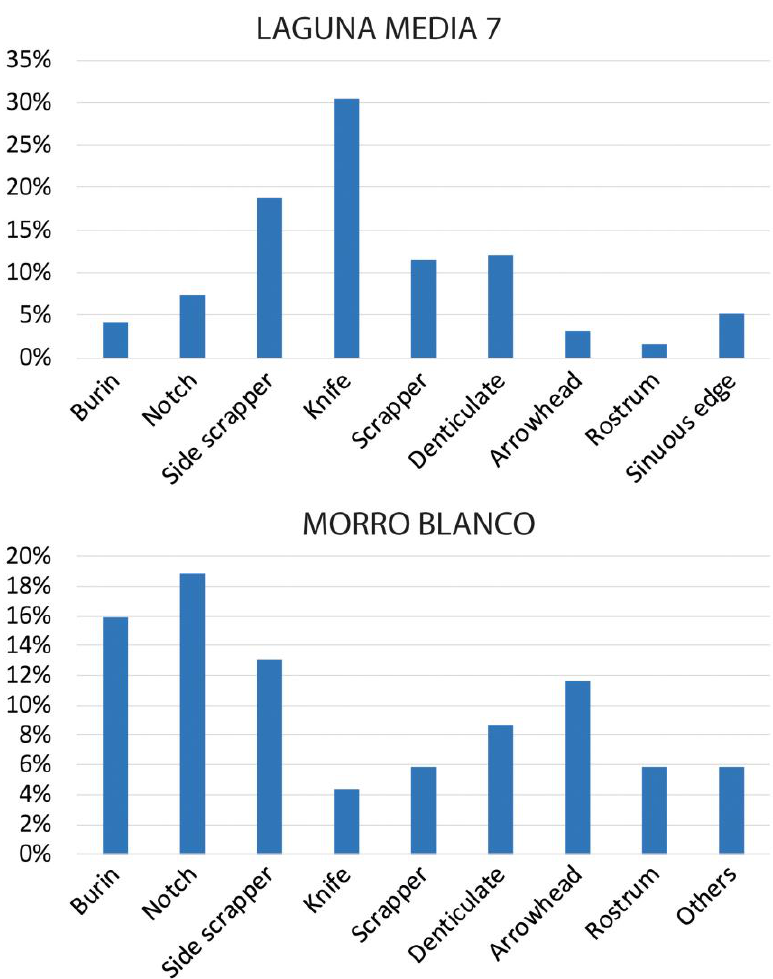
Figure 4. Distribution (percentages) of TFU on Laguna Media 7 and Morro Blanco. t Table 4. Frequencies and normalized residuals for the Transformative TFU from Laguna Media 7 and Morro Blanco - x 2 and Monte Carlo